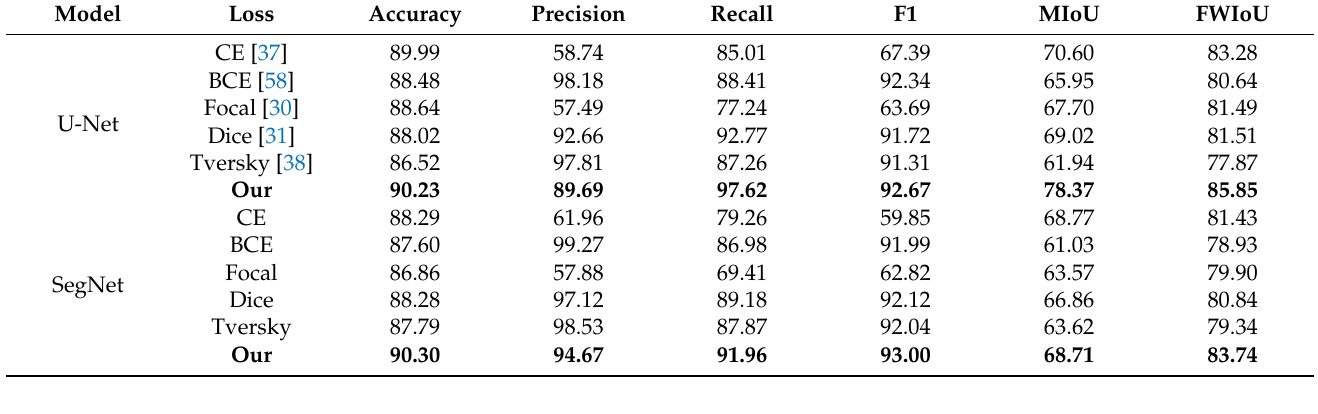
Table 8. The impact of various loss functions on network performance metric (%).